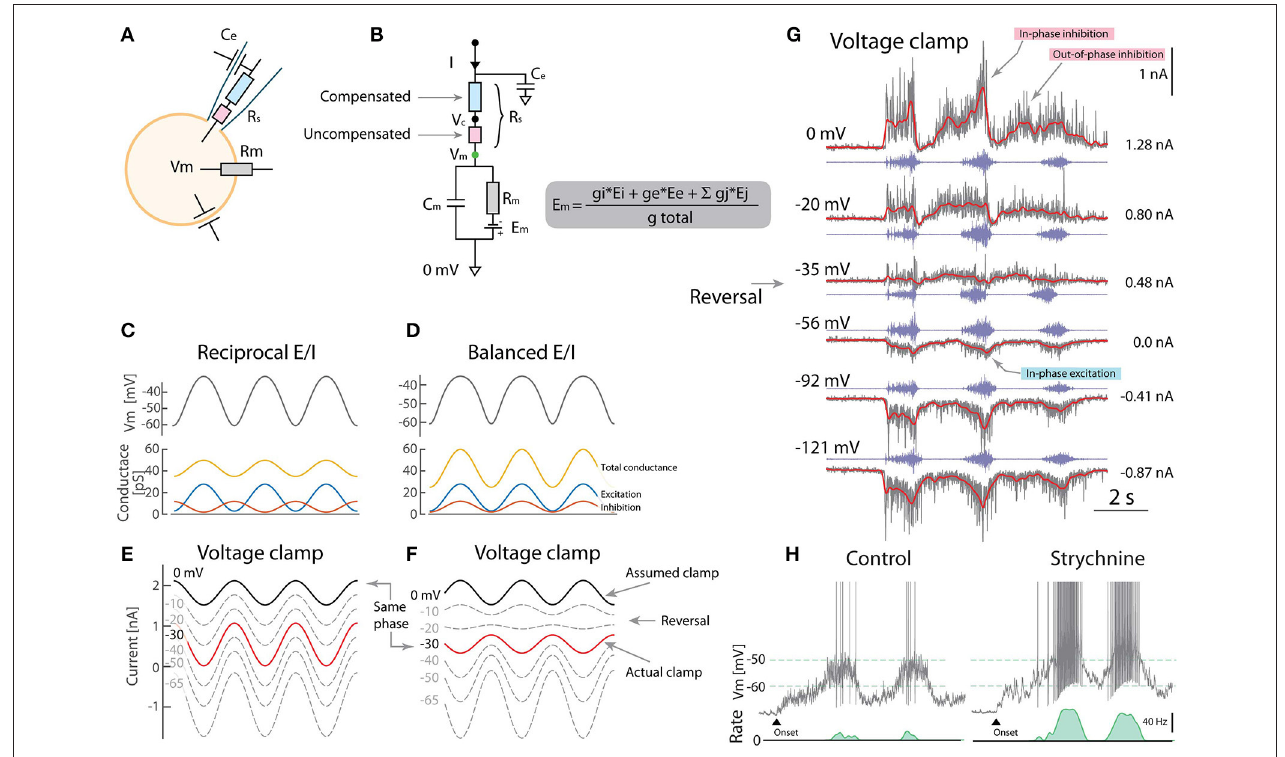
FIGURE 1 | Caveats using voltage clamp to resolve excitation and inhibition. (A) Whole-cell VC can be decomposed into electrical components including the pipette series resistance ( R s ). (B) Partial compensation for R s introduces a disparity between clamped potential ( V c ) and V m due to uncompensated resistance (red). (C) Reciprocal model for rhythmic V m has alternating E/I. ( R m = 20 M (cid:127) , E leak = − 70 mV ). (D) Balanced model has concurrent E/I and also rhythmic V m . (E) Outward currents measured using VC is assumed to be inhibition when clamping 0mV (black). The actual clamp is at − 30 mV (red). (F) Balanced E/I spuriously appears as reciprocal when the actual clamp is below synaptic reversal potential (“same phase” cf. red in F and black in E ). (G) VC-recording of a putative motoneuron with blocked spikes (with intracellular QX314) at different holding potentials (gray: current, red: mean, blue: nerve). Reversal of phase (arrow) is consistent with the balanced scheme (F) although with a smaller out-of-phase inhibition (indicated). (H) Blocking inhibition (strychnine) increases firing rate also consistent with the balanced scheme. (G) provided by A. Alaburda (current levels indicated, right) and (H) adapted with permission (Vestergaard and Berg,